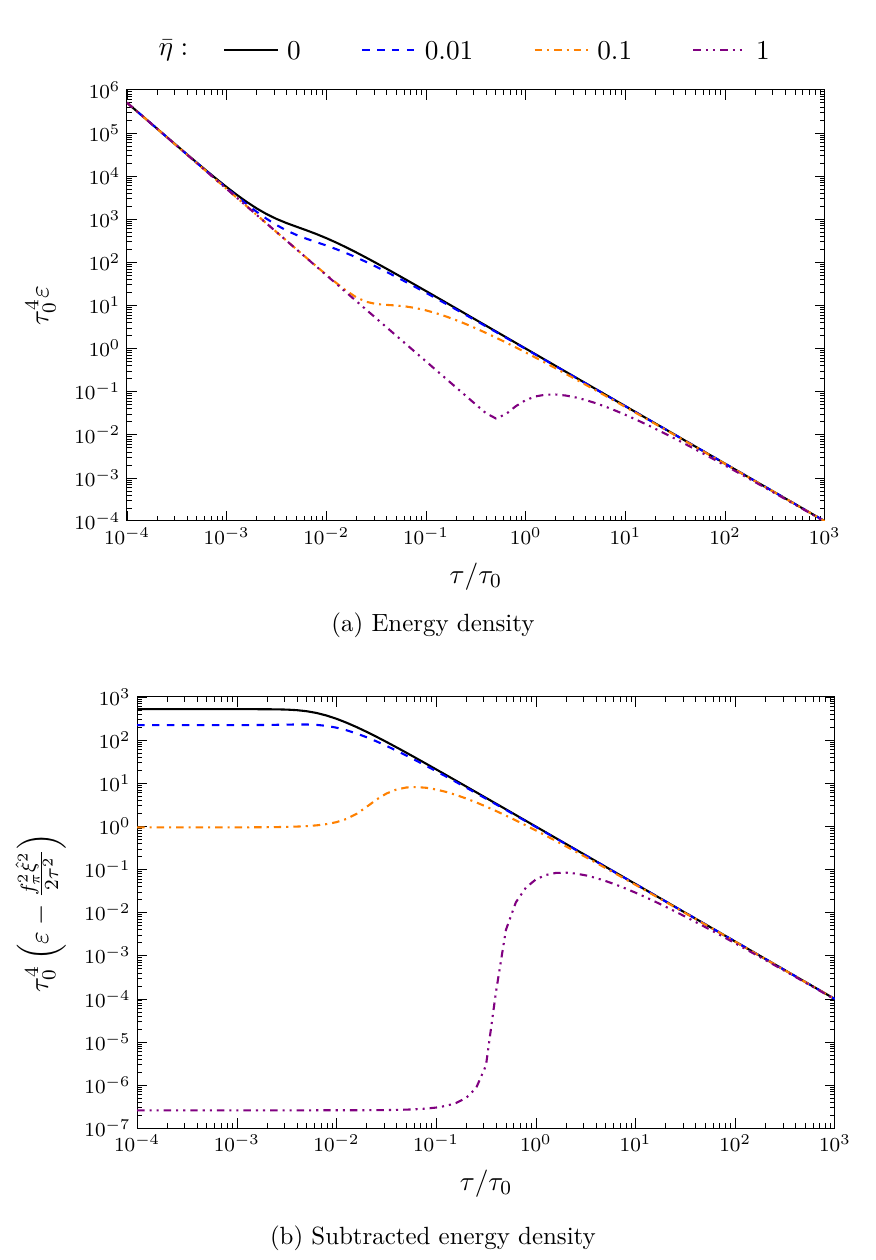
Figure 1. (a) Numerical results for the energy density as a function of τ for superfluid Bjorken flow with non-zero shear viscosity η . The different curves correspond to different values of ¯ η ≡ η/T 3 . To make the plot, we have chosen the parameters in the equation of state and the integration constants to be n = π 2 / 30 , k = 1 / 6 , ˆ ξ = 1 / 10 , and τ 0 = 1 /f π . (b) The same data as in (a), but with the ˆ ξ 2 / 2 τ 2 subtracted, highlighting the difference between the dominant early-time behaviour ε ≈ f 2 π curves for different ¯ η